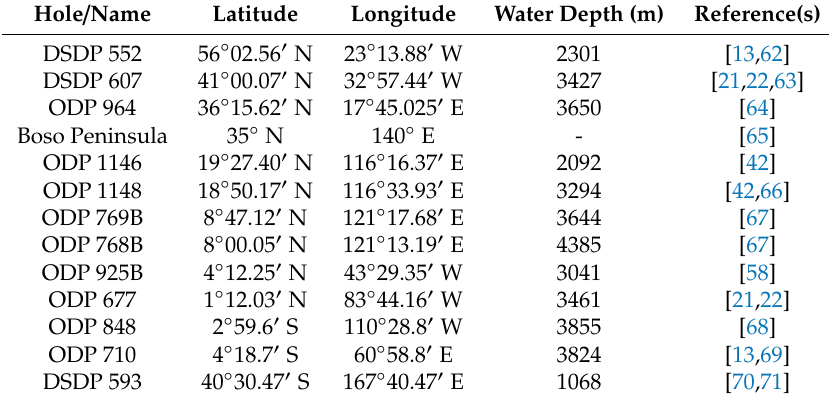
Table 2. Location of Deep Sea Drilling Project (DSDP), ODP Sites, and onshore references used for